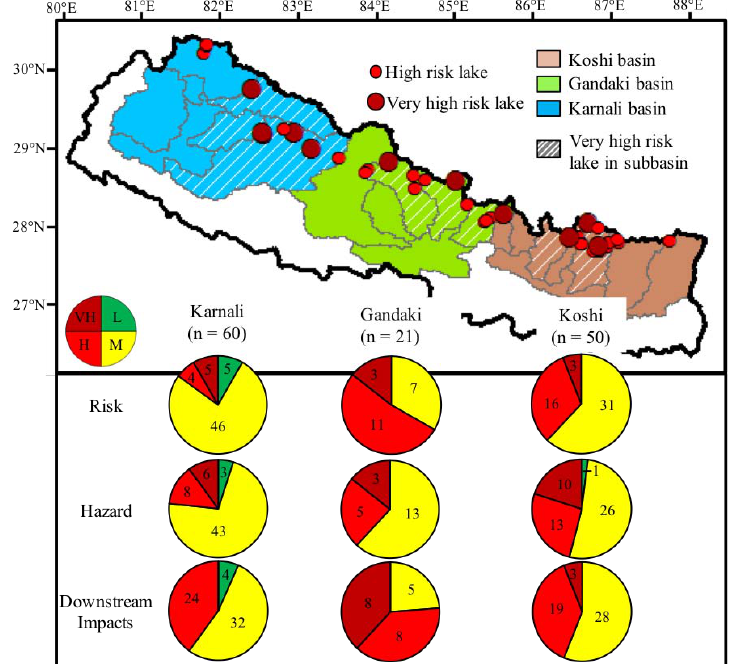
Figure 5. Distribution of risk, hazard, and downstream impacts classifications (pie charts) for each basin. The map shows all lakes classified as very high or high risk with hatched lines showing a sub-basin that has at least one lake classified as a very high risk.